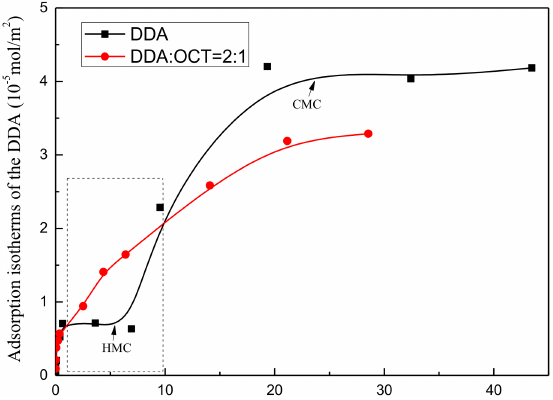
Figure 7. Comparison between the adsorption isotherms of the single DDA and mixed DDA/ octanol (OCT)